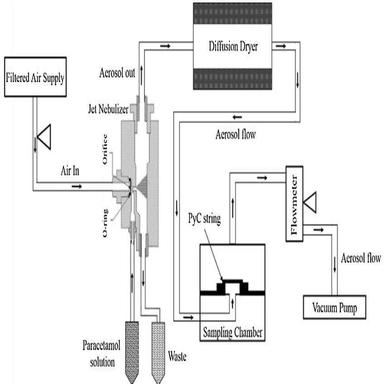
Schematic describing the jet nebulizer system for deposition of paracetamol nanoparticles on pyrolytic carbon (PyC) strings.